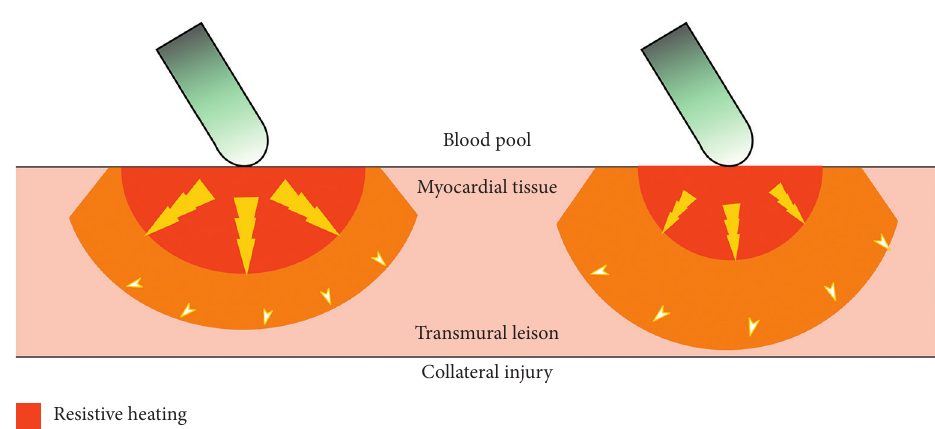
Figure 1: Comparison between HPSD approach and CAT. Lesion dimensions of radiofrequency ablation and heating distribution in myocardial tissue are demonstrated. HPSD approach and CATcould create comparable lesion size. HPSD approach results in an ablation lesion that is heated directly from the catheter during the resistive phase (red part), while, in CAT, myocardial tissue is largely heated because of conductive heating (golden yellow